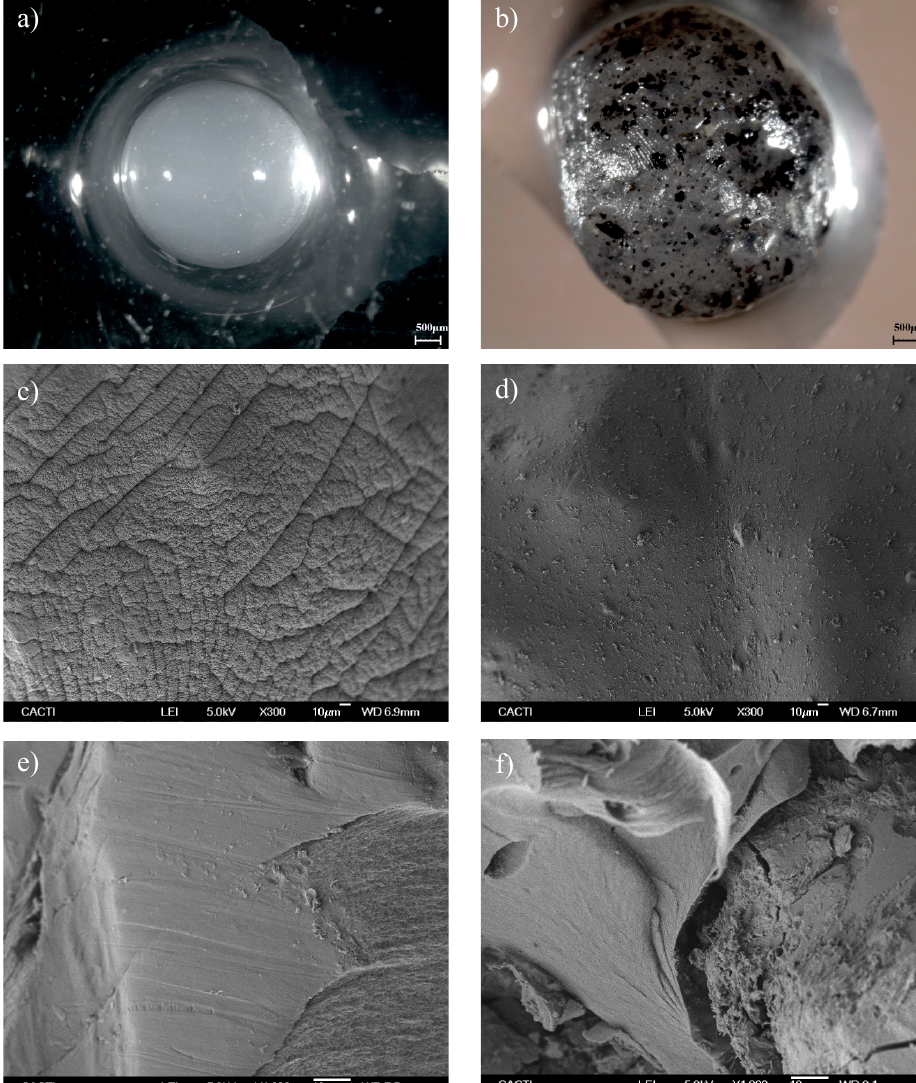
Figure 1. Macro view and SEM micrographs of alginate-based biopolymers: ( a , c , e ) from the biopolymer composed only for alginate, and ( b , d , f ) from the biopolymer with alginate and grape marc. The biopolymer that only contains alginate presented a high capacity for the elimina- tion of organic acids and sugars from the CSW, with a maximum removal for acetic acid (100%) and glucose (98.5%), respectively. For almost all ions, metals as well as biosurfactant extract, the percentage of removal was about 50%, except for boron (40.4%) and silicon (39.2%). On the other hand, the alginate-based biopolymer tunned with grape marc, also showed good elimination rates for the same families, organic acids, and sugars, but for other types. For instance, the highest percentage of elimination was for lactic acid (99%) and for all the sugars tested this was greater than 99%. Moreover, this biopolymer had obtained good removal of metals such as iron (98.5%) and zinc (96.8%) as well as for cations, like manganese (90.4%), and anions, such as phosphate (75%). However, the amount of biosurfactant extract eliminated was of Table 2. Removal of some inorganic solutes and biomolecules (%) with the calcium alginate-based biopolymers after 24 h of equilibration time.